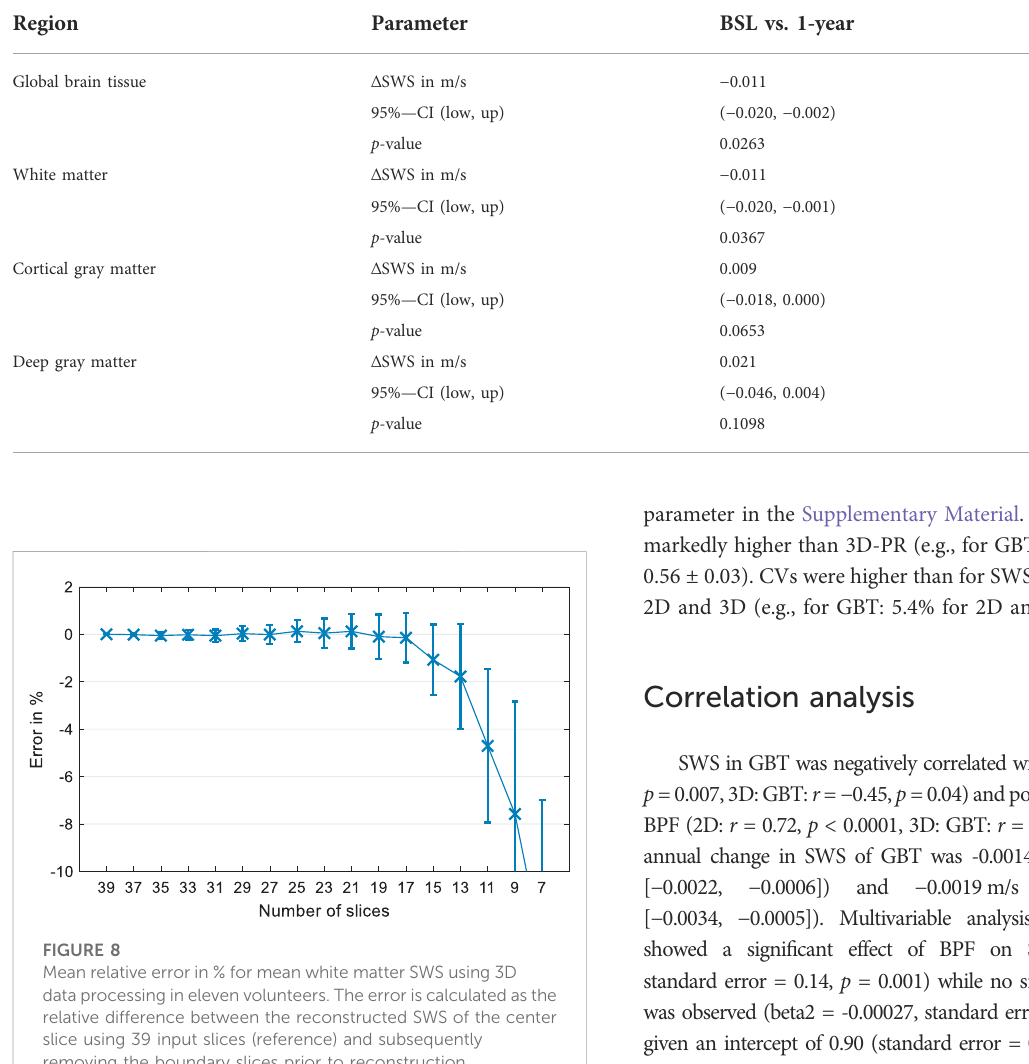
TABLE 3 SWS results of 1-year follow-up examination compared to the baseline and 1-day measurement as references for 3D data processing. Absolute changes in SWS with 95% con fi dence intervals and Holm-Bonferroni corrected p -values are given for global brain tissue, white matter, cortical gray matter, and deep gray